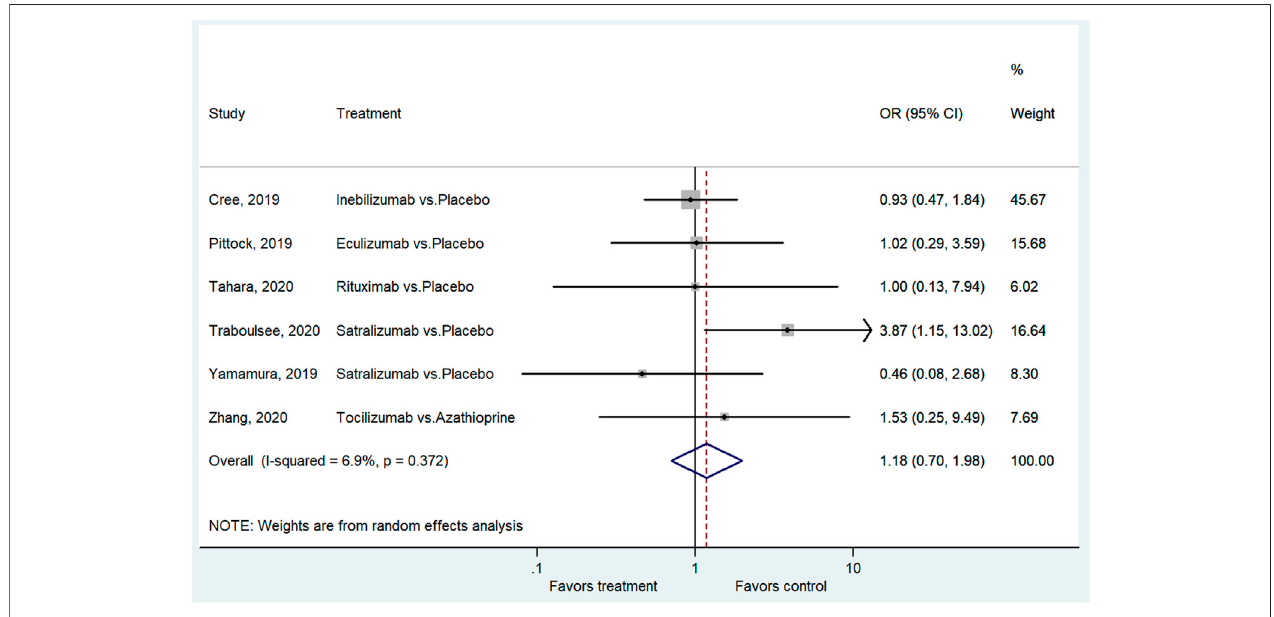
FIGURE 5 | Forest plot of AEs.